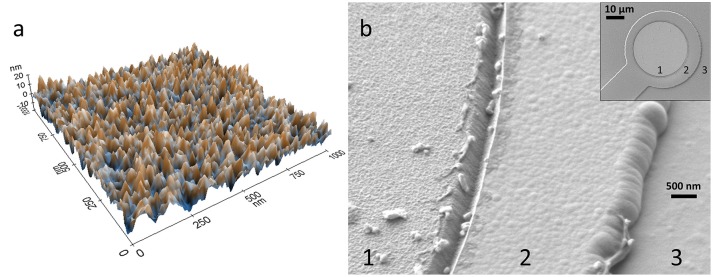
Topological imaging of IBAD TiN. (a) AFM image of IBAD TiN surface of sample 2, and (b) SEM images of a 30 μm IBAD TiN microelectrode, where 1 is IBAD TiN on Ti, 2 is Si3N4 on Ti, and 3 is Si3N4.